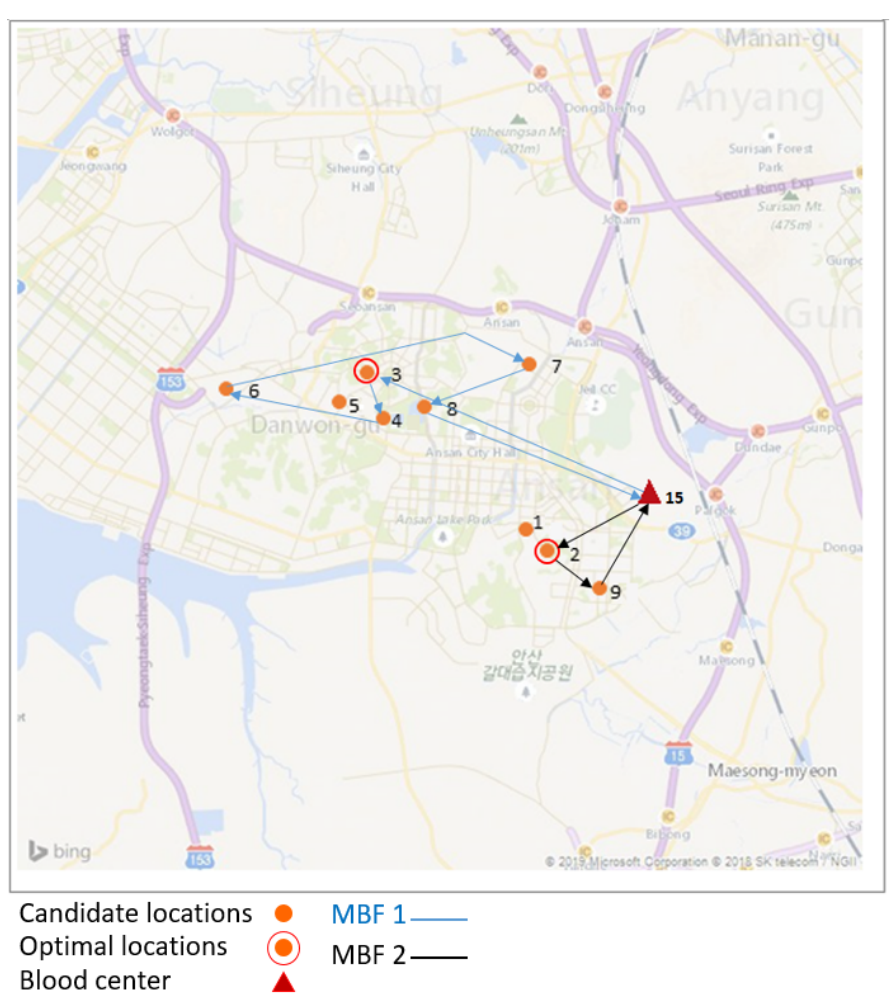
Figure 5. Optimal locations of mobile blood facilities 1 and